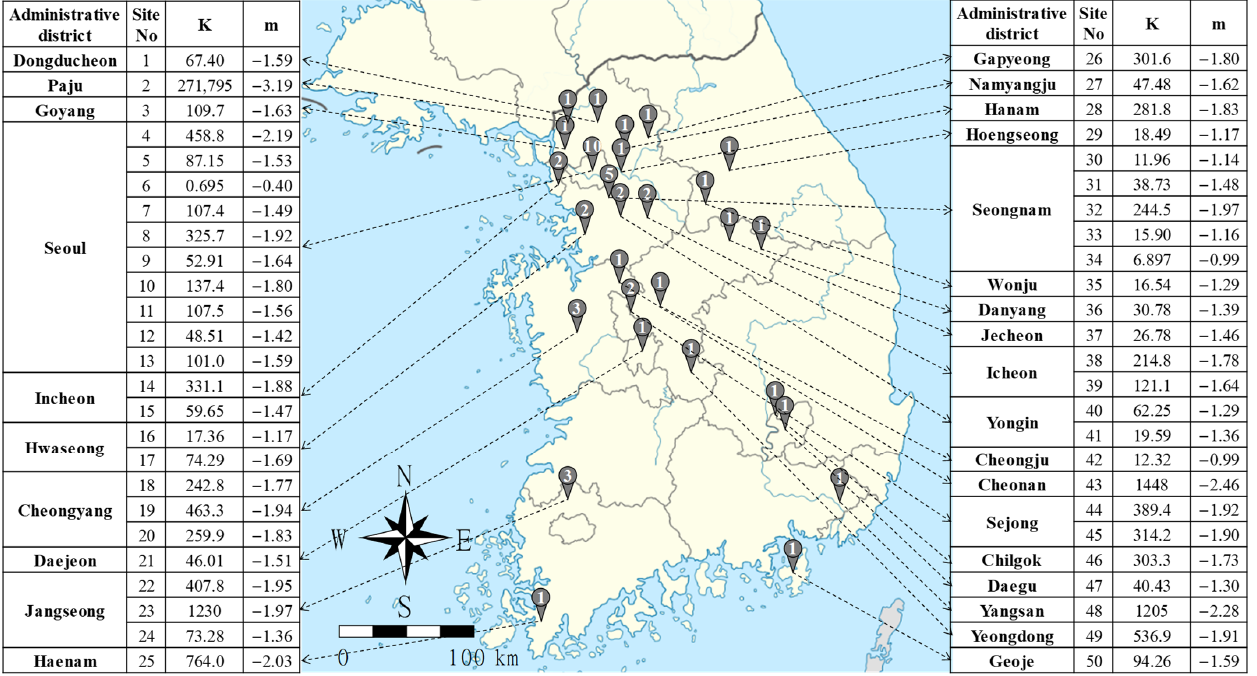
Figure 2. Locations of 50 diverse construction sites by administrative district.